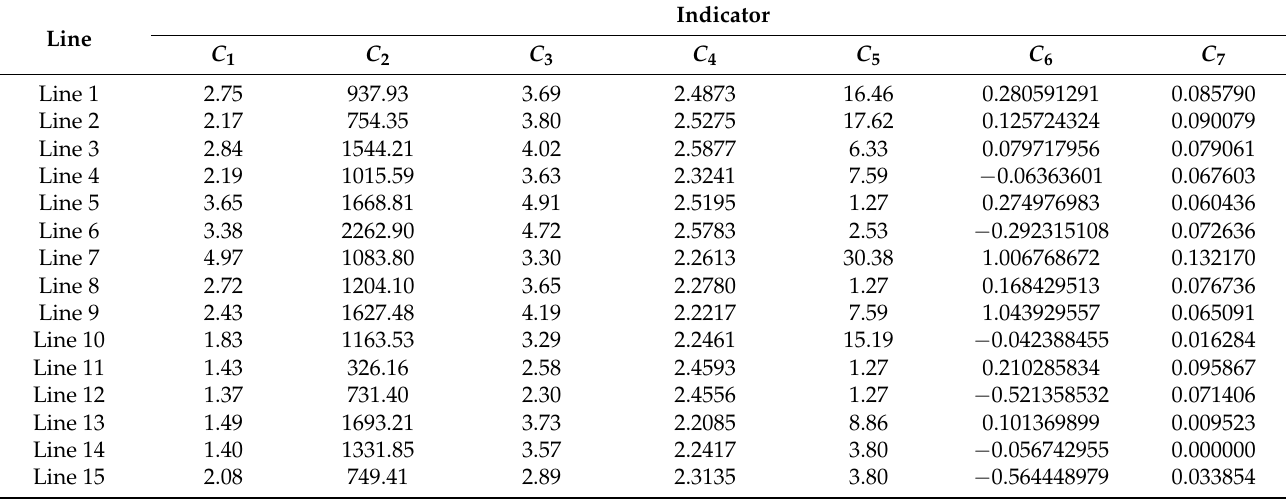
Table 6. Initial decision matrix for the construction sequence of Line